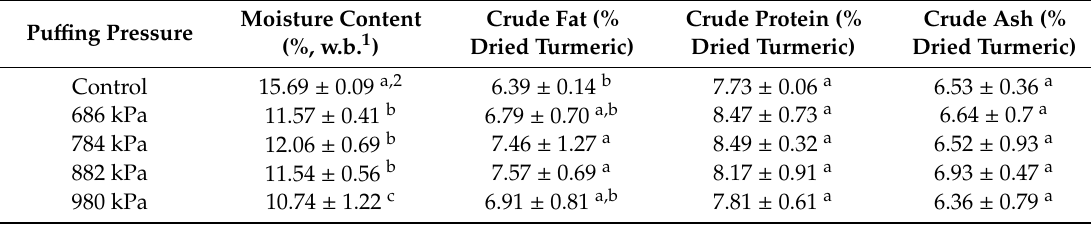
Table 1. Changes in proximate analysis induced by pu ffi ng ( n = 3).